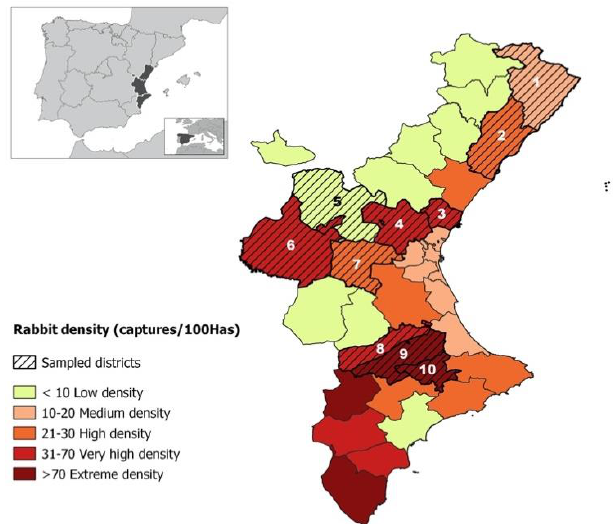
Figure 1. Districts of the Valencian Region (El Baix Maestrat (1) La Plana Alta (2), Camp de Morvedre (3), El Camp de T ú ria (4), Serranos (5), La Plana Utiel-Requena (6), Hoya de Buñol (7), La Costera (8), La Vall d’Albaida (9), El Comtat (10)), colored according to rabbit